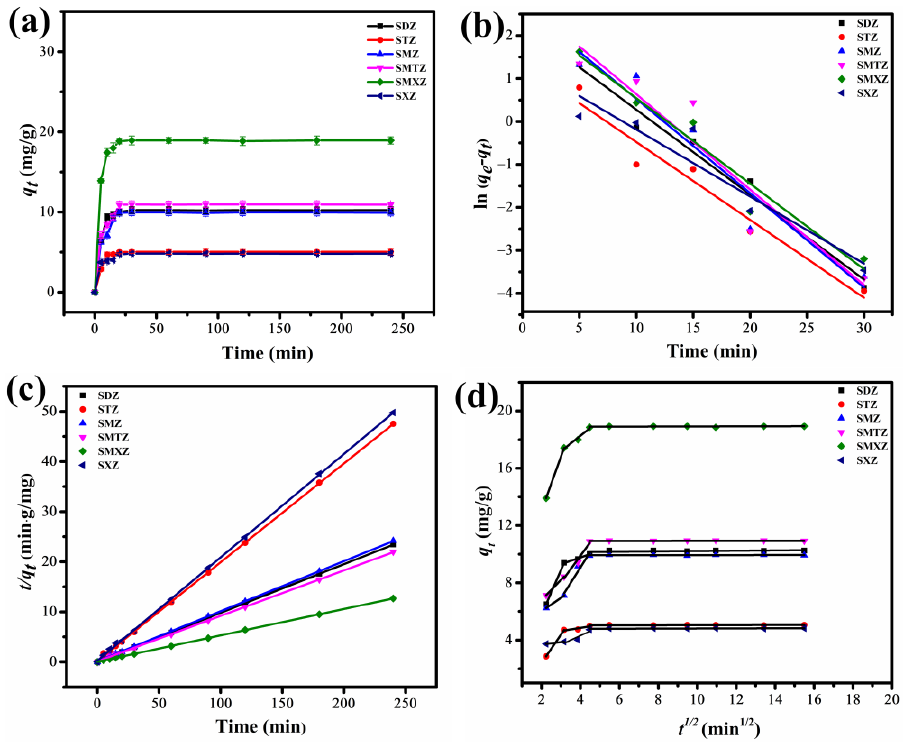
Figure 4. ( a ) Adsorption kinetics of sulfonamides on BiFeO 3 /MXene, ( b ) pseudo-first-order model, ( c ) pseudo-second-order model, and ( d ) intra-particle diffusion model at pH 6. Table 1. Fitted parameters of pseudo-first-order and pseudo-second-order models for the adsorption of sulfonamides in a mixed